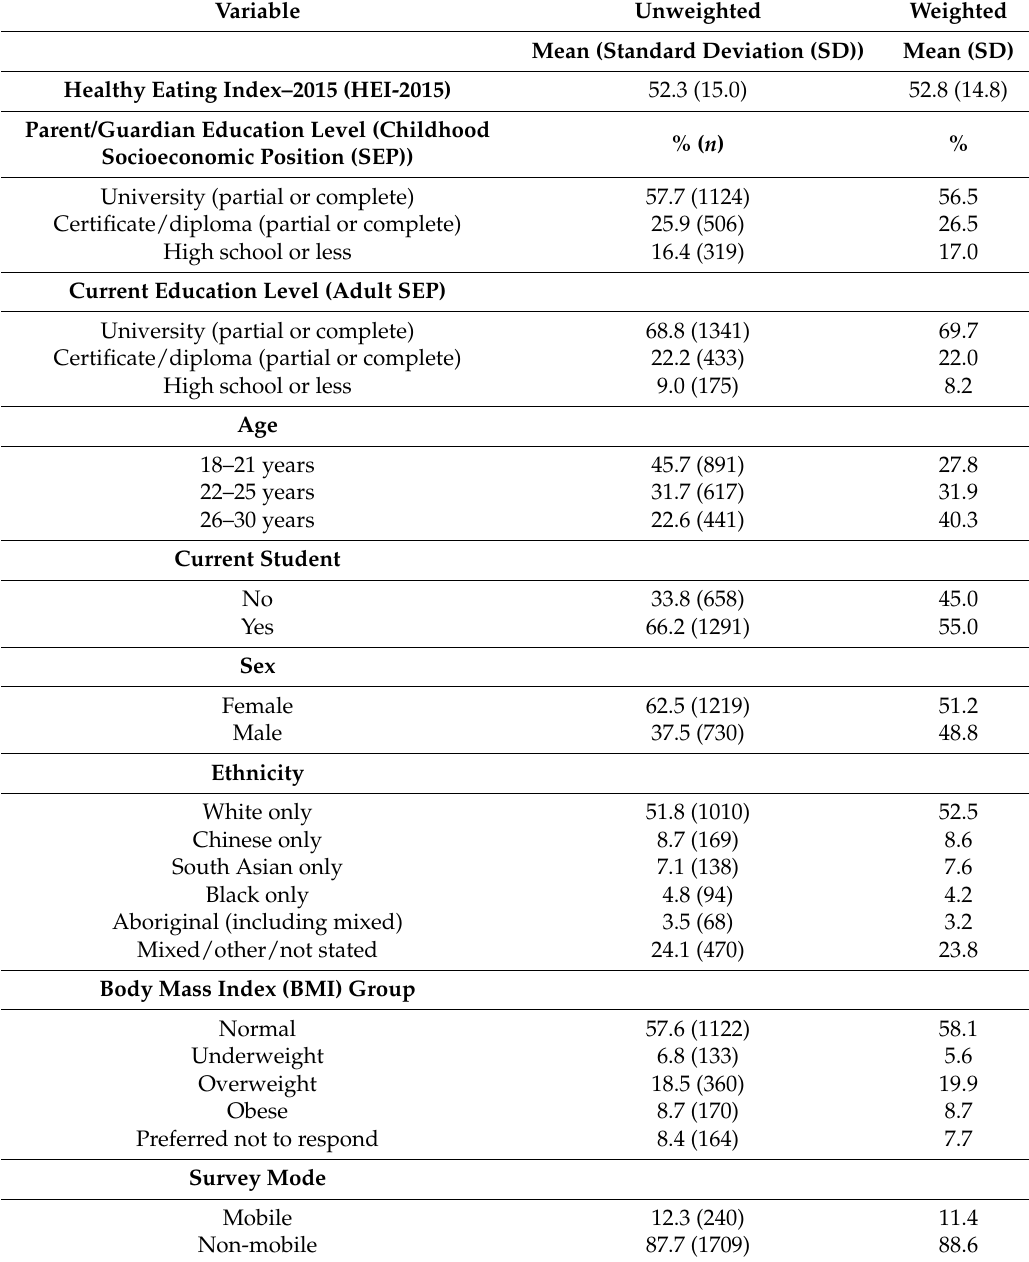
Table 1. Participants in the 2016 wave of the Canada Food Study ( n =